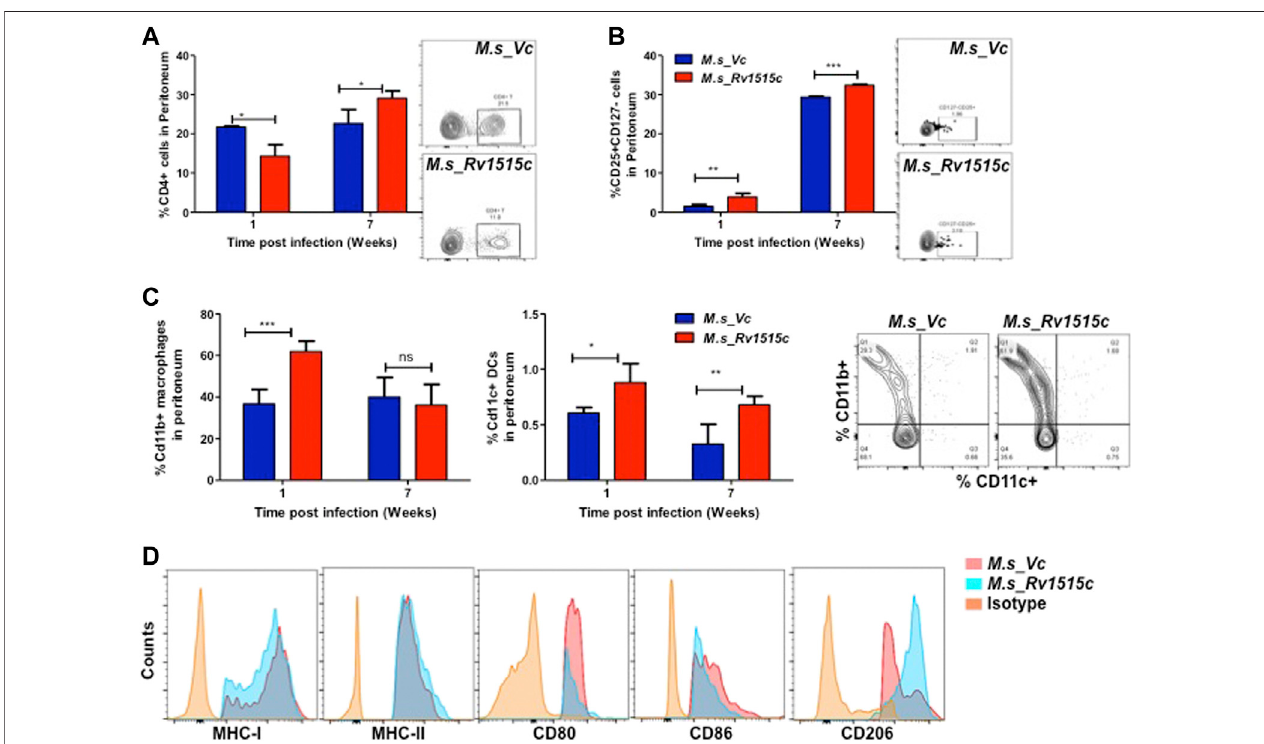
FIGURE 9 | Phenotypic pro fi ling of peritoneal APCs after infection with recombinant M. smegmatis expressing M. tb Rv1515c. C57BL/6 female mice ( n = 6) were infected intraperitoneally with M. s _Rv1515c and M. s _Vc. After 1 and 7 weeks post infection, the peritoneal macrophages were extracted and single cell suspensions were stained with antibodies to detect the percent of T cell sub-populations. (A) CD4 + T cells; (B) Percent Treg cell expressing of CD25 + CD127 − on gated CD4 + T cells wereexamined; (C) CD11b + expressingmacrophagesandCD11c + expressingdendriticcells.Inset:representativedotplotoftheCD11b + CD11c + cellsat1 week time point. (D) Expression of antigen presentation molecules (MHCI, MHCII), co-stimulatory molecules (CD80, CD86) and M2-macrophage polarization marker CD206. Data are represented as mean ± SD and statistical analysis was performed using two-way ANOVA followed by Bonferroni test. * p < 0.05, ** p < 0.01, *** p < 0.001, ns- nonsigni fi